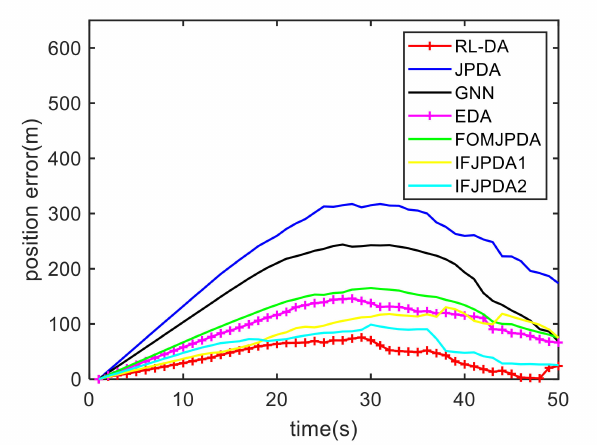
Figure 25. Comparison of the position errors for Target 1 in Case 2.